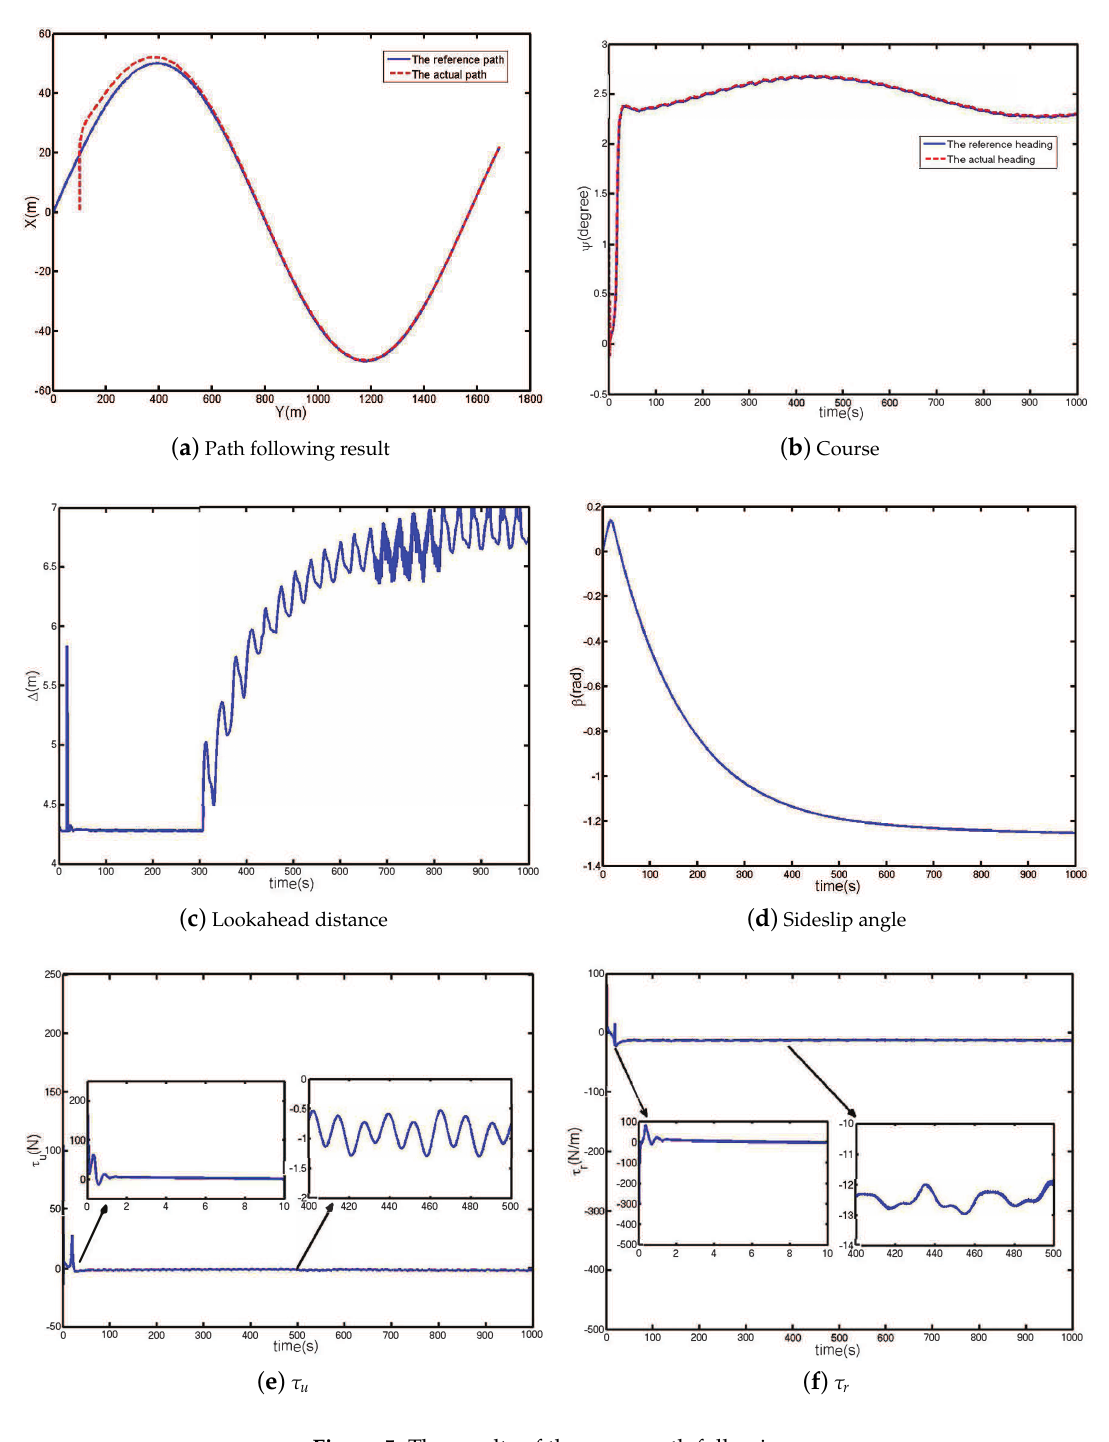
Figure 5. The results of the curve path